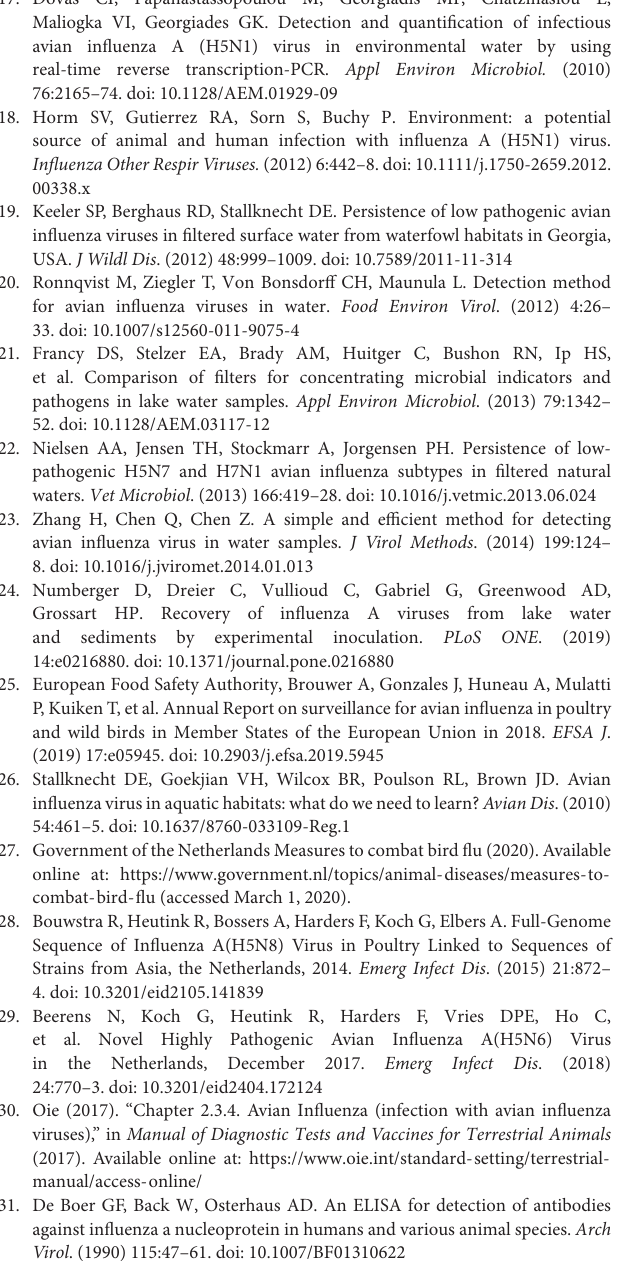
Figure S1 | Maximum likelihood phylogenetic tree based on the nucleotide sequence of the HA segments from influenza strains related to A/Chicken/Netherlands/17013178-006-010/2017. The evolutionary history was inferred by using RaxML (39) and utilizing the maximum likelihood method based on the General Time Reversible (GTR) model with a gamma-distributed variation of rates and 1000 bootstrap replicates. Bootstrap support values are indicated at the corresponding branch. The optimal phylogenetic tree is shown, and is drawn to scale. The GISAID accession numbers of the viruses are shown in the trees. The H10N7 viruses isolated from the hens and from the water sample are marked in